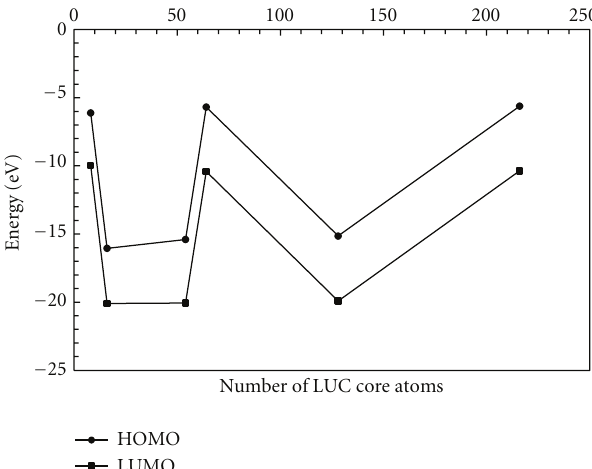
Figure 8: HOMO and LUMO energies that correspond to di ff erent core sizes of AlP nanocrystals.